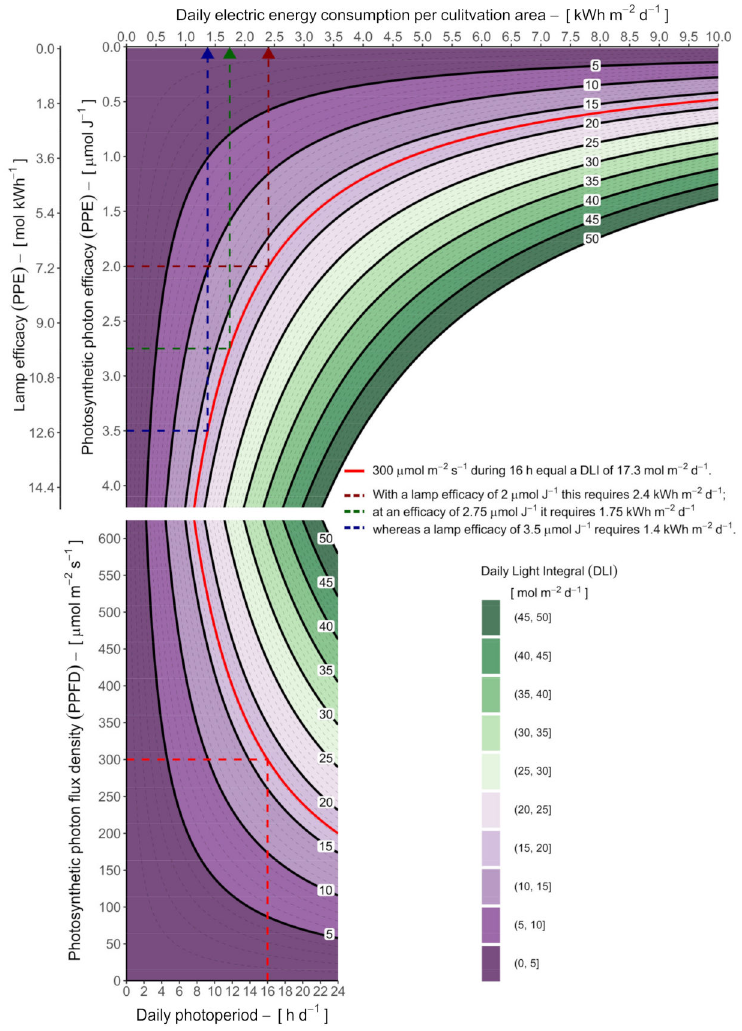
Figure 5. Daily PAR output of sole-source lighting (DLI lamps , mol · m − 2 · d − 1 ) and the corresponding electric energy consumption per cultivation area (E el, lamps , kWh · m − 2 · d − 1 ) based on the photoperiod (h · d − 1 ) and PPFD ( µ mol · m − 2 · s − 1 ) settings; as well as the efficacy of the lamps (PPE, µ mol · J − 1 ) used, expressed also in the equivalent units typically found commercially (mol · kWh − 1 ) for convenience. The red dashed lines indicate the growth-room settings selected in this study while the contiguous red line is the resulting DLI lamps . The three dashed lines of different colors in represent the lamp efficacies by matching their corresponding energy consumptions on the